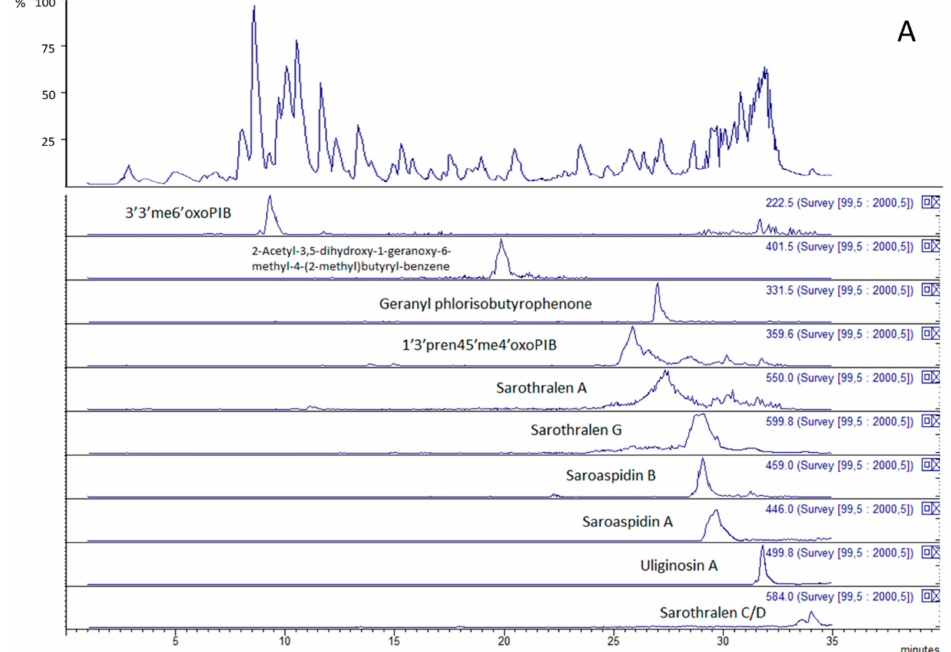
Figure 2. Representative chromatogram obtained from LC-ESI(-) ion trap analysis of H. japonicum extract (panel A) and extracted ion chromatograms of the characterized phloroglucinol derivatives. Each chromatographic trace shows the peak(s) associated with a specific phloroglucinol, whose name is indicated. 3 (cid:48) 3 (cid:48) me6 (cid:48) oxoPIB: 3 (cid:48) ,3 (cid:48) -dimethyl-6 (cid:48) -oxo-phlorisobutyrophenone; 1 (cid:48) 3 (cid:48) pren45 (cid:48) me4 (cid:48)